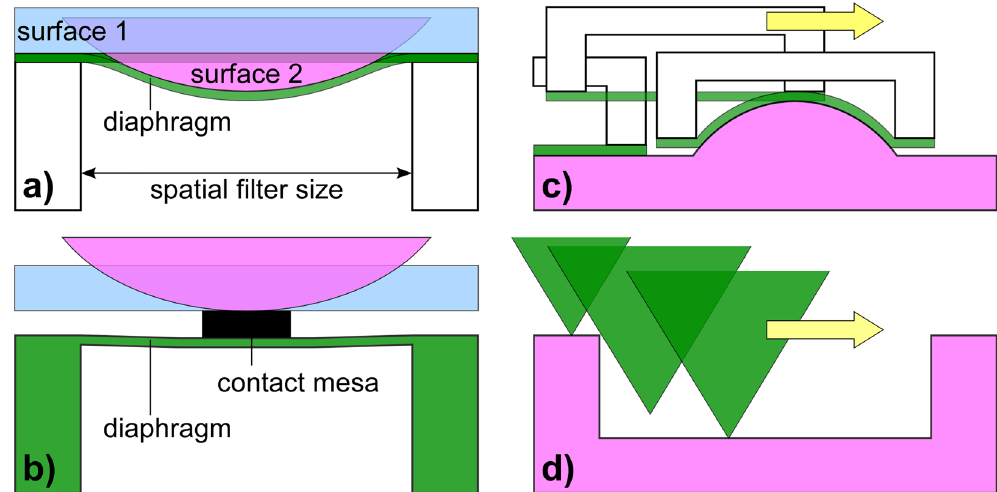
Figure 1. ( a ) Our architecture implementing mechanical spatial filtering. Contact with a flat surface (surface 1) does not deflect the diaphragm, but a large signal is generated when a surface feature of matching size (surface 2) is encountered. ( b ) A standard diaphragm-type sensor. A signal is generated by pressure from a flat surface as well as one with a curved feature. ( c ) Our concept resembles a “reversed” profilometer, in which the indenting object is imaged by a deflecting surface. ( d ) Standard mechanical profilometry, in which a tip scans over a surface to obtain its